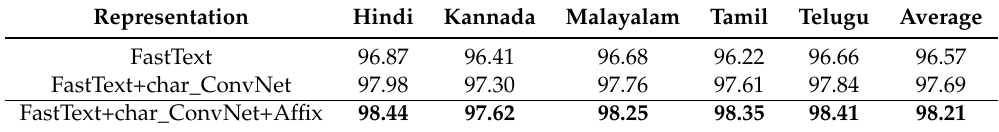
Table 4. Impact of different word representations on BiLSTM-CRF tagger Accuracy(%).